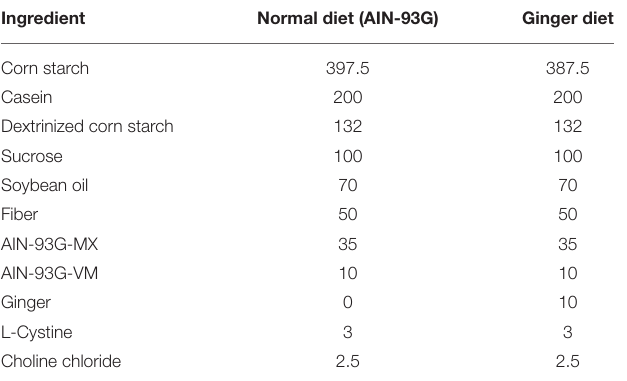
Frontiers in Medicine |